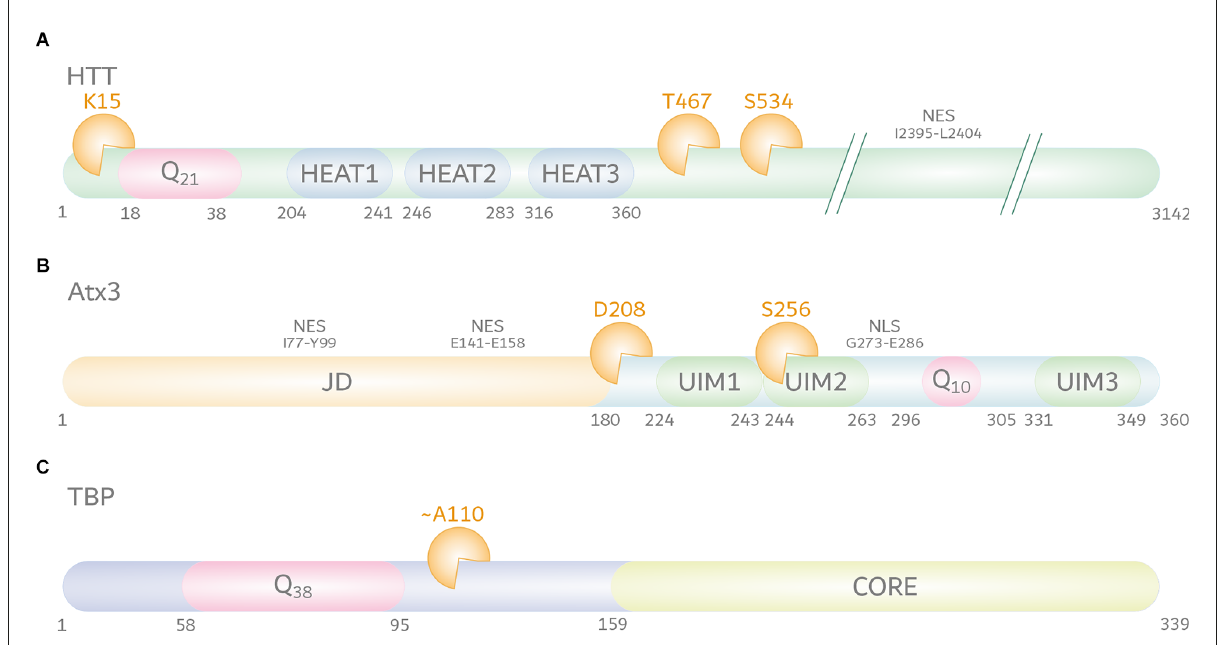
FIGURE2 Calpain cleavage sites in huntingtin protein (HTT), ataxin-3 (Atx3), and TATA box-binding protein (TBP). (A) HTT (UniProt-ID: P42858) features, aside from its N-terminal polyQ tract, five HEAT repeats, three of the latter being localized within the first 500 amino acids. Moreover, HTT contains a C-terminal nuclear export signal (NES) between amino acid positions I2395-L2404. The best characterized calpain cleavage sites are at amino acids K15, T467, and S534. (B) Atx3 (UniProt-ID: P54252-2) consists of an N-terminal proteolytic Josephin domain (JD) carrying two nuclear export signals (NES) between amino acid positions I77-Y99 and E141–E158, and two to three ubiquitin interaction motifs (UIMs). Two UIMs are located N-terminally of the polyQ stretch, while the last isoform-dependent UIM is located at the C-terminus of the protein. A nuclear localization signal (NLS) between amino acid positions G273-E286 is located between UIM2 and the polyQ stretch. The best characterized calpain cleavage sites were mapped to amino acids D208 and S256. (C) The location of calpain cleavage sites in TBP (UniProt-ID: P20226-1) is predicted to be C-terminal to its polyQ tract and N-terminal to its core DNA-binding domain, around amino acid position A110. However, the exact cleavage site remains